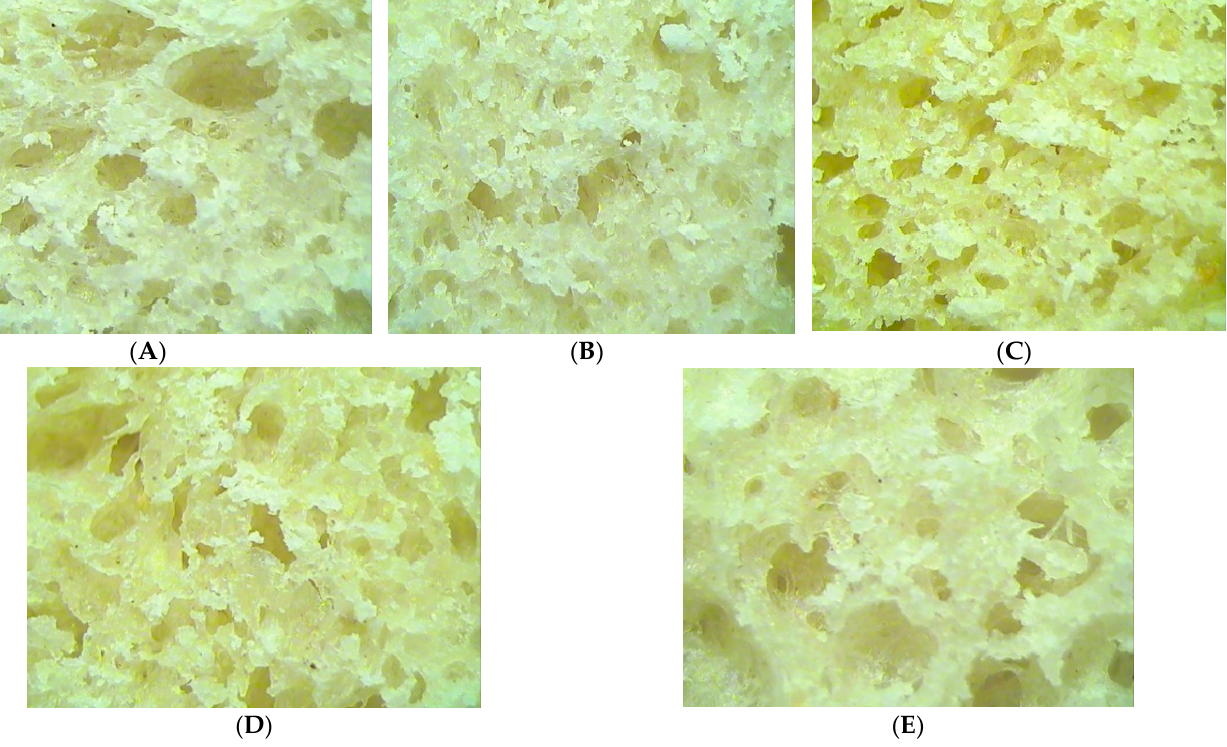
Figure 4. Structure of wheat dough with germinated lupin flour (GLF) at different levels: 0% ( A ), 5% ( B ), 10% ( C ), 15% ( D ) and 20% ( E